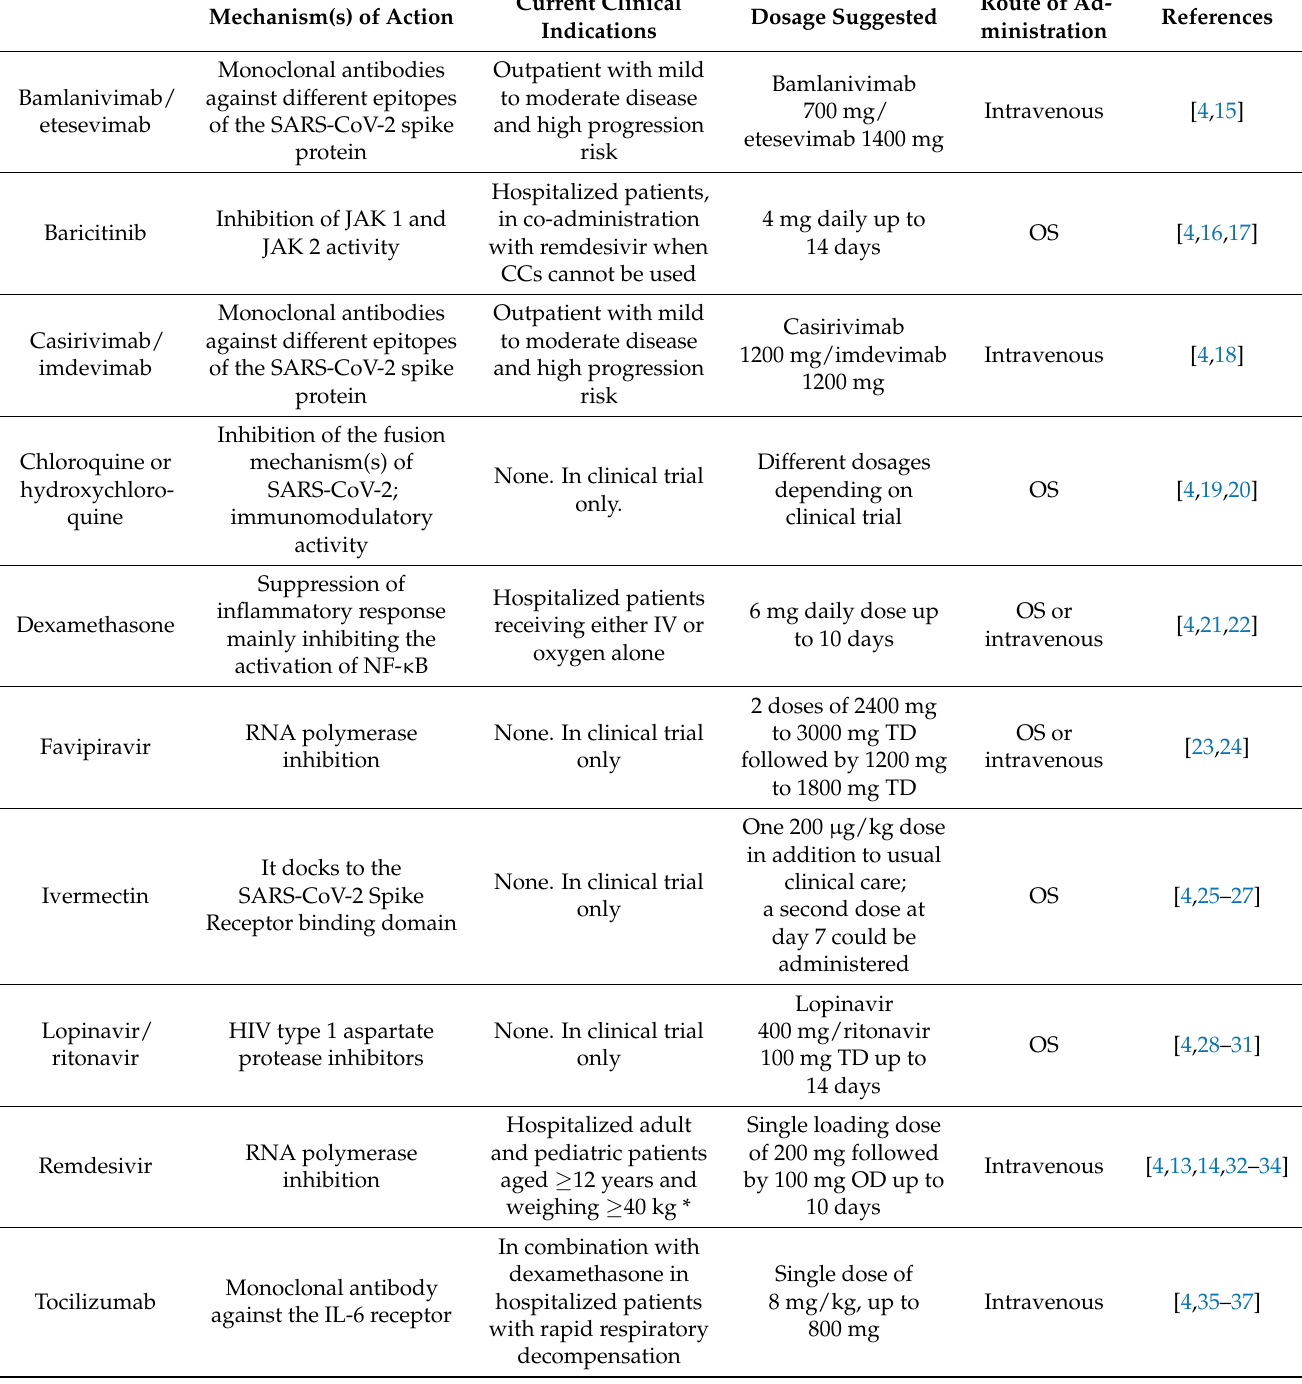
Table 2. Rationale, current clinical indications and dosages of COVID-19